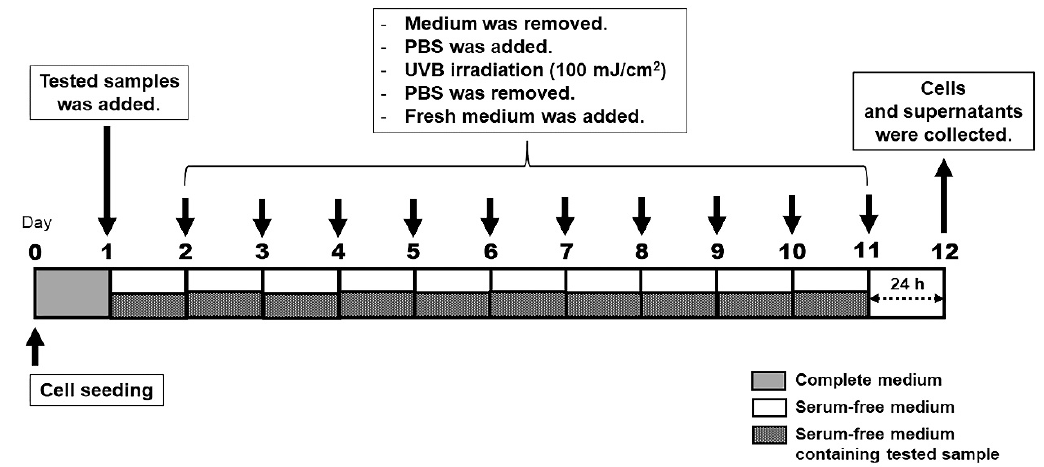
Figure 2. Schematic illustration of the protocol of repeated UVB irradiation.